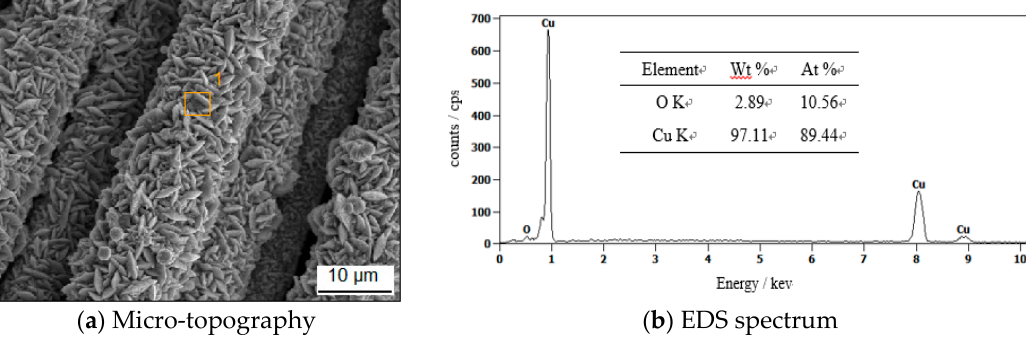
Figure 4. EDS spectrum of copper-plated carbon fibers: ( a ) Micro-topography, ( b ) EDS spectrum.